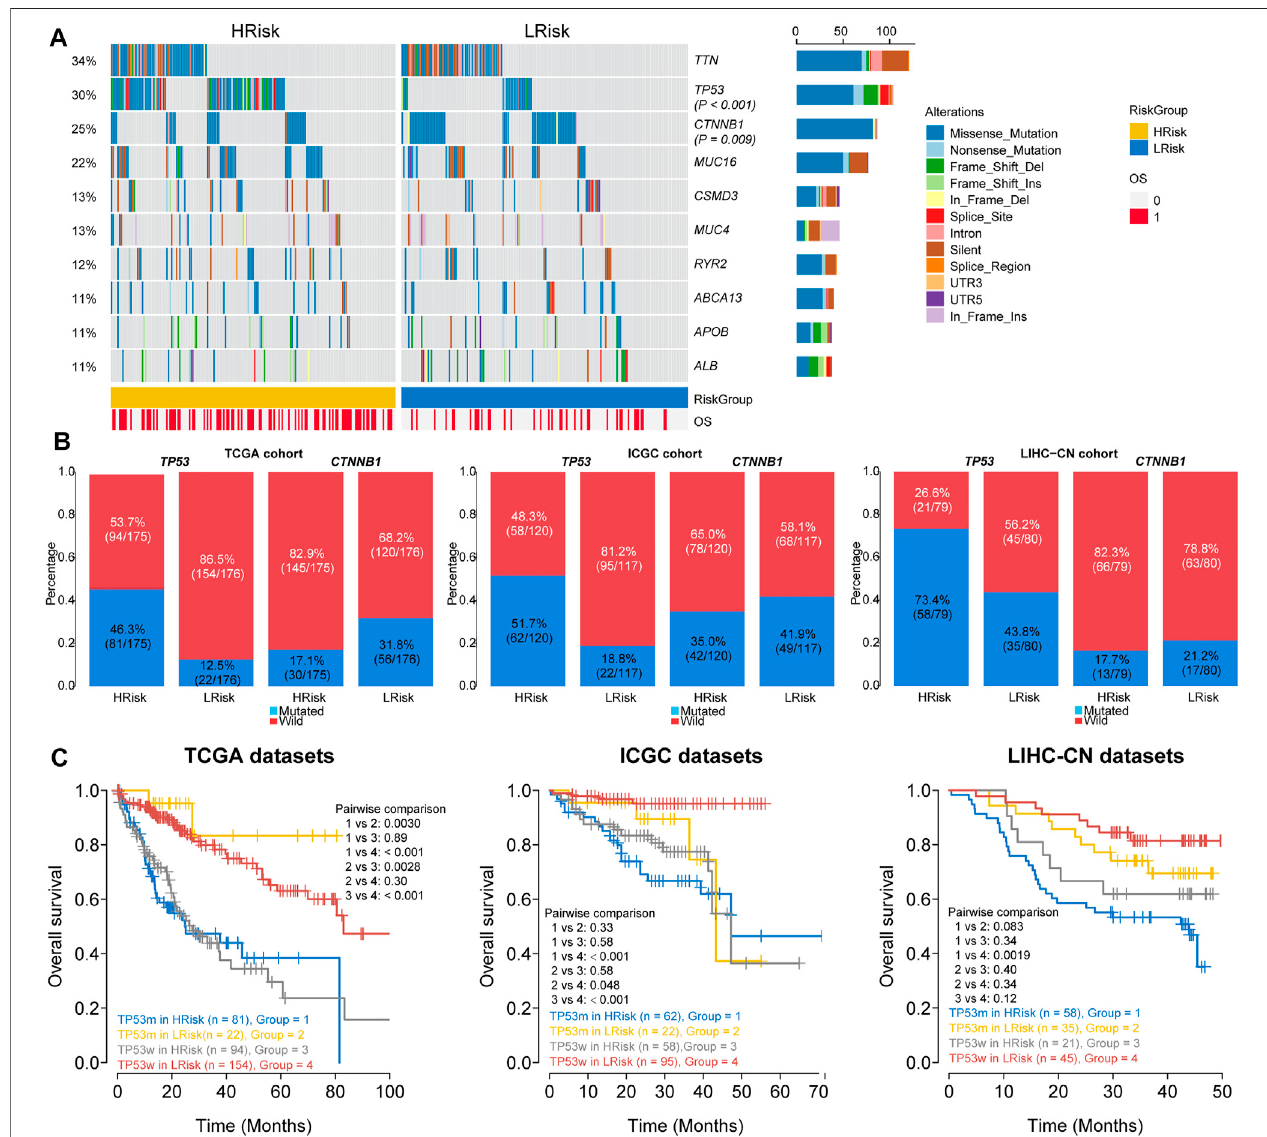
FIGURE 7 | Analysis of mutation characteristics in HRisk and LRisk. (A) Oncoprint showing the mutational landscape of mutations with mutated greater than 10% in TCGA-HCC. Mutations of TP53 and CTNNB1 were signi fi cantly mutated in HRisk (Fisher ’ s exact test, p < 0.001) and LRisk (Fisher ’ s exact test, p = 0.009) groups, respectively. (B) Barplots showing the similar distribution of TP53 and CTNNB1 mutation between two riskgroups in TCGA cohort ( TP53 : 46.3 vs . 12.5%, p < 0.001; CTNNB1 :17.7 vs .31.8%, p =0.007),ICGC cohort( TP53 :51.7 vs .18.8%, p < 0.001; CTNNB1 :35.0 vs .41.9%, p =0.2883),and LIHC-CNcohort( TP53 :73.4 vs . 43.8%, p < 0.001; CTNNB1 : 17.7 vs . 21.2%, p = 0.5439), respectively. (C) Kaplan – Meier curve analysis of overall survival is shown for patients classi fi ed according to TP53 mutation status and the riskgroup in three cohorts. TP53w, TP53 -sequence wild type; TP53m, TP53 -sequence mutant